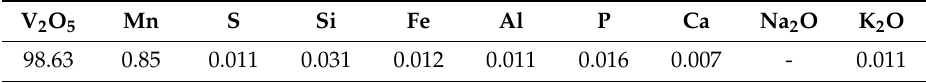
Table 2. Chemical composition of the vanadium pentoxide product (wt.